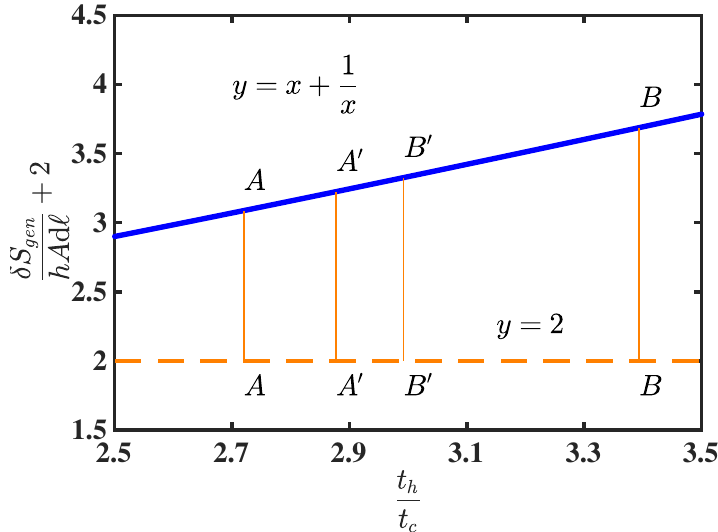
Figure 13. The ranges of the dimensionless entropy generation distribution of two cases in the hook function.